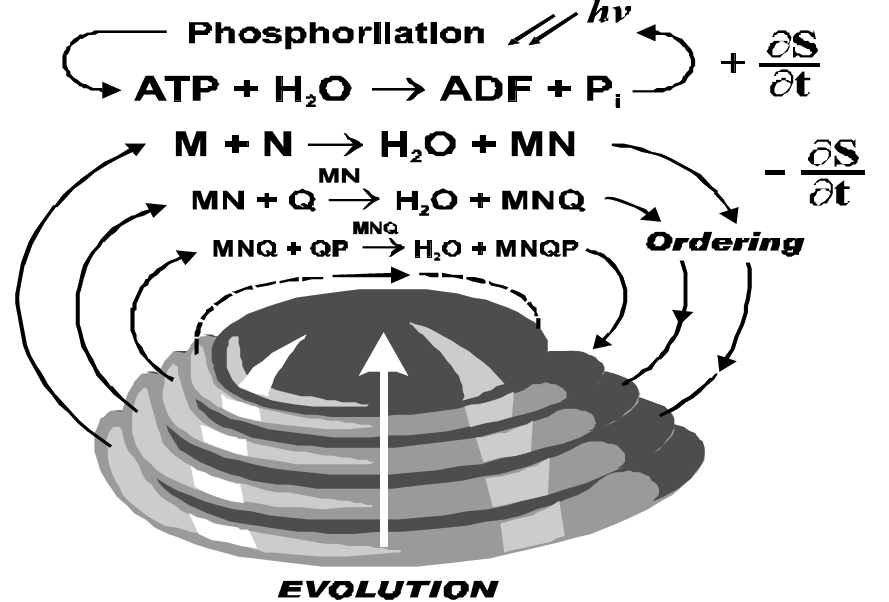
Figure 3. The model of ATP-related